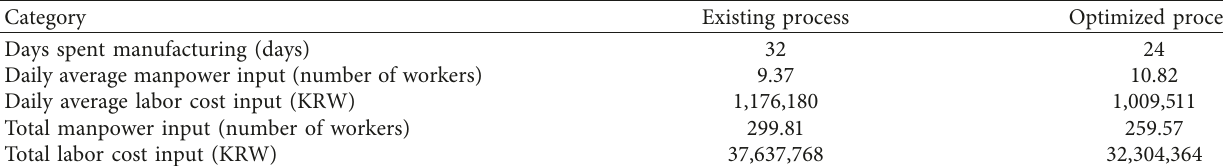
Table 3: Productivity comparison.